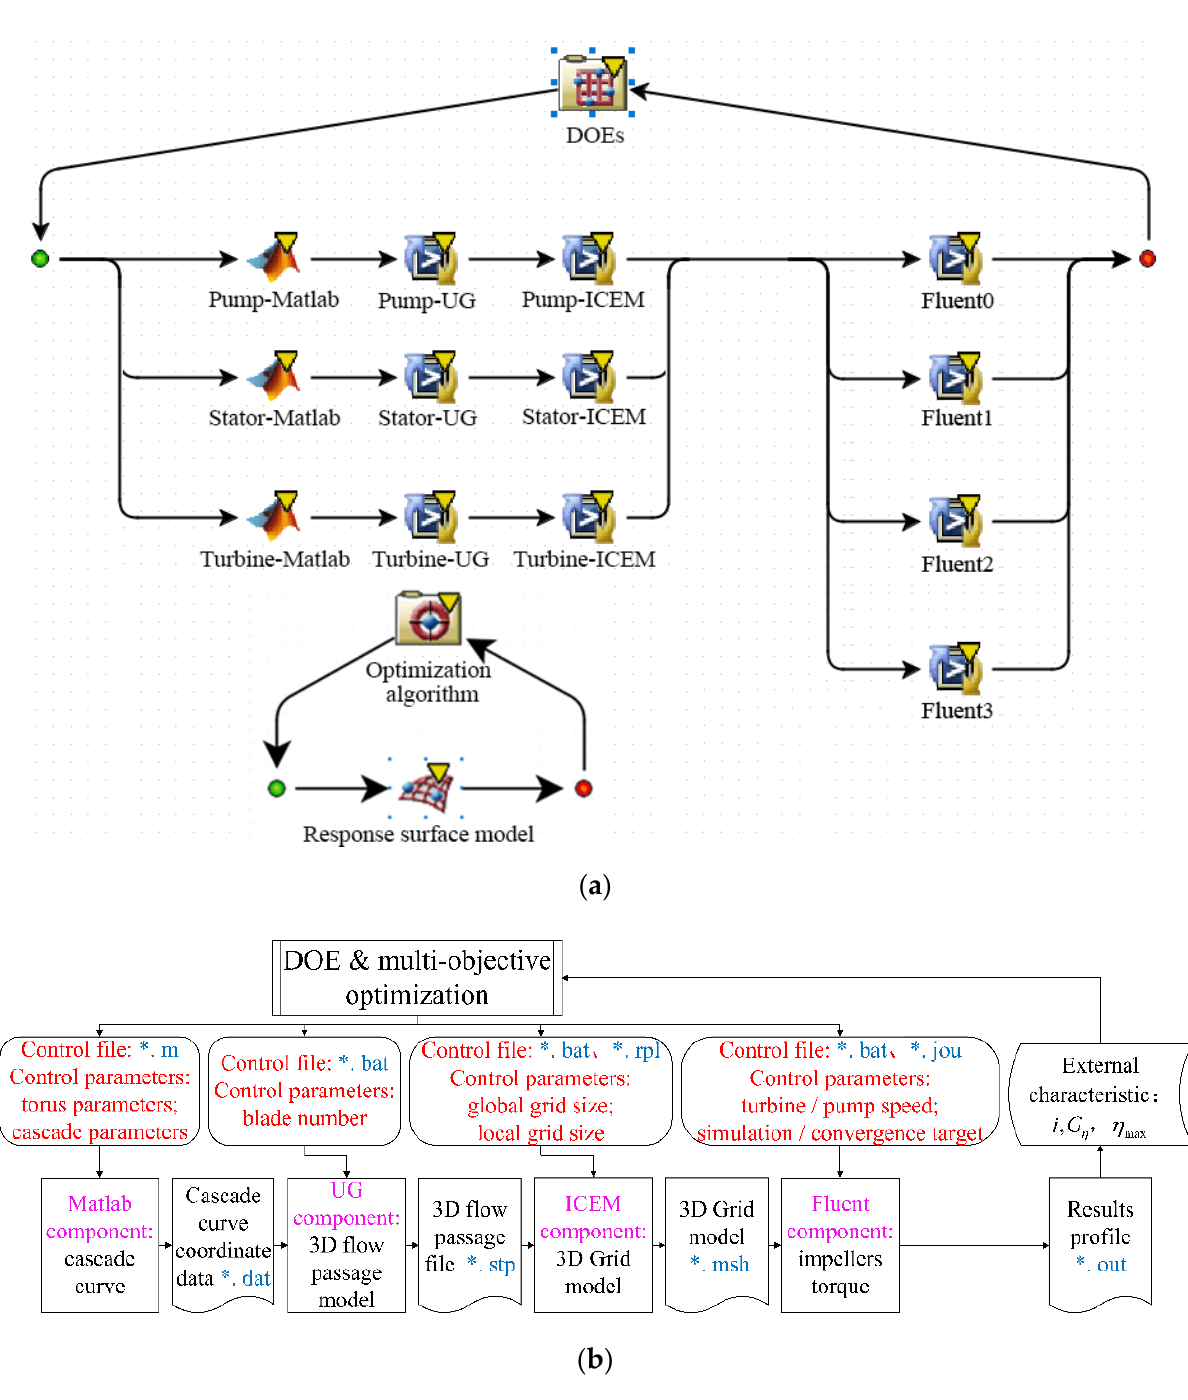
Figure 9. Integrated optimization system model of 3D cascade system for hydrodynamic torque converter ( a ) integrated optimization system (Fluent 0: i = 0, 0.4; Fluent 1: i = 0.5, 0.6; Fluent 2: i = 0.7, 0.8; Fluent 3: i = 0.9, 1.0); ( b ) flow-process diagram.